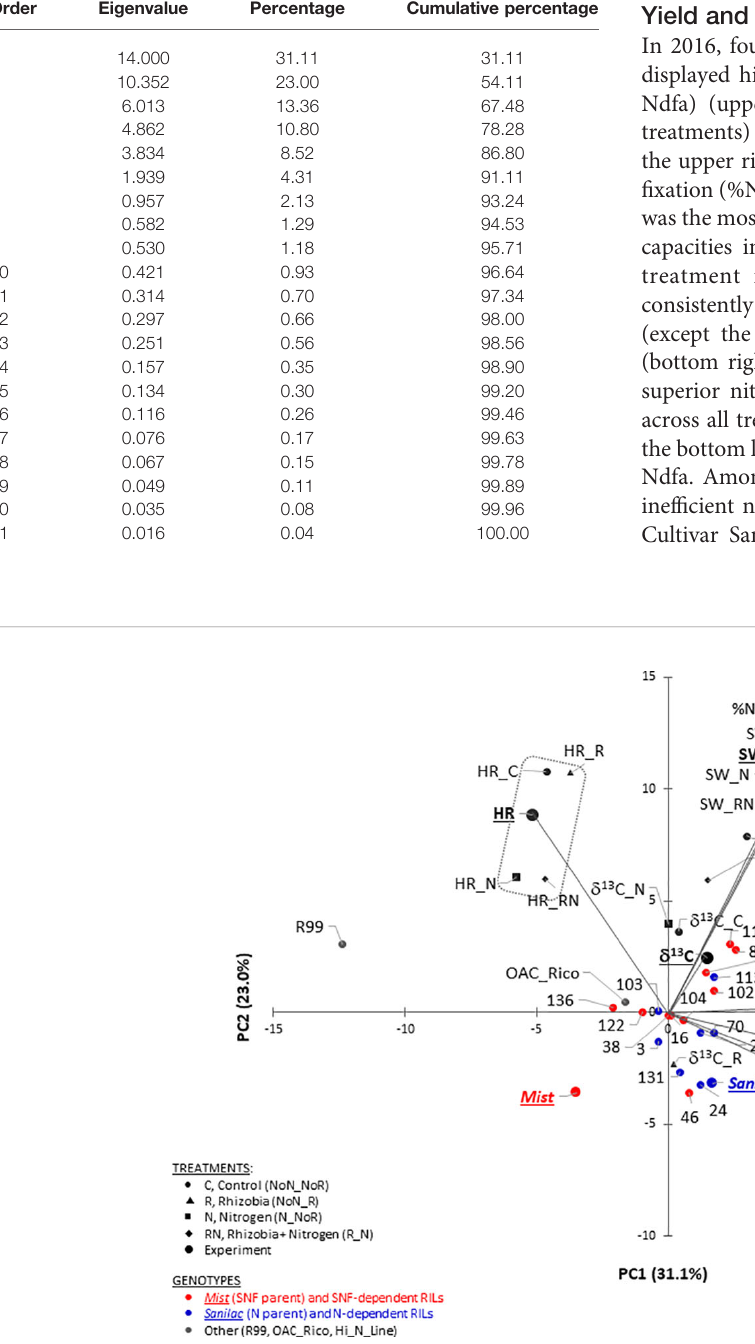
FIGURE 2 | Genotype-trait (GT) biplot analysis of 22 common bean genotypes for traits evaluated at the Elora research station (ERS), ON in 2017 and 2018. Cumulatively, the fi rst two principal components (PC) explained 54.1% of the variability. Traits: percent nitrogen derived from atmosphere (%Ndfa, %), yield (YD, kg ha -1 ), carbon isotope discrimination ( d 13 C, ‰ ), fl owering (DF, days), maturity (DM, days), plant height (PH, cm), harvestability (HR, scale 1 to 5), seed weight (SW, g) and leaf chlorophyll content (SPAD, SPAD